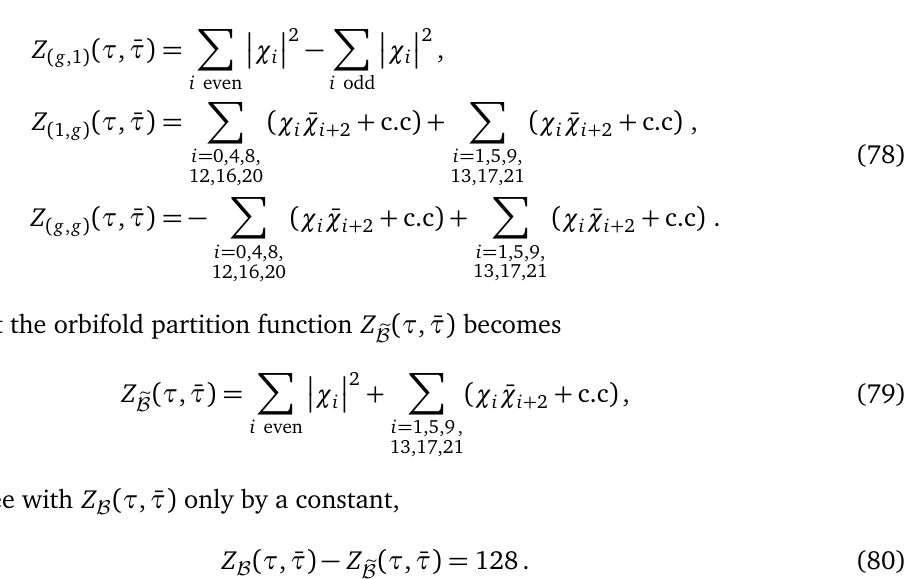
Table 18: SO ( 8 ) Their characters are denoted by χ respectively. We highlight the primary related to the (cid:90)